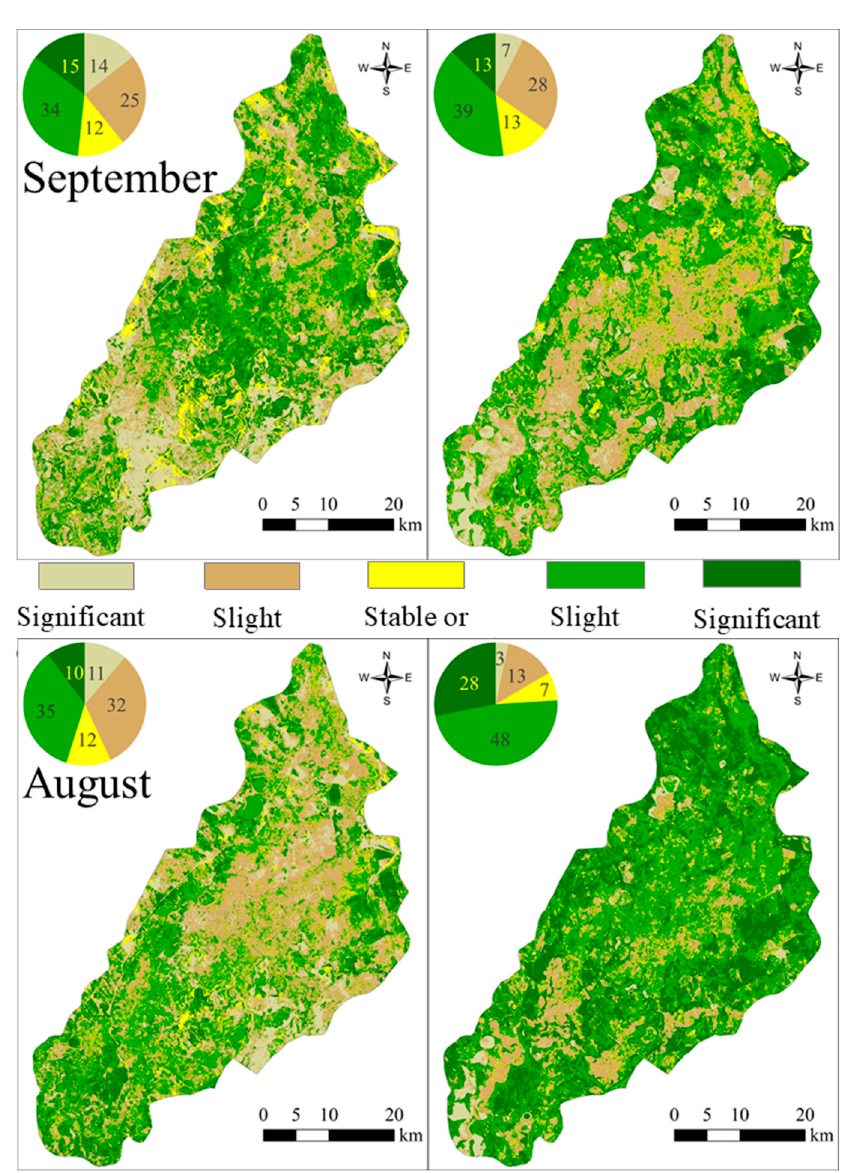
Figure 5. Spatial distribution of averaged NDVI in the growing season pre- (left panel) and post- (right panel) ecological water replenishment period.